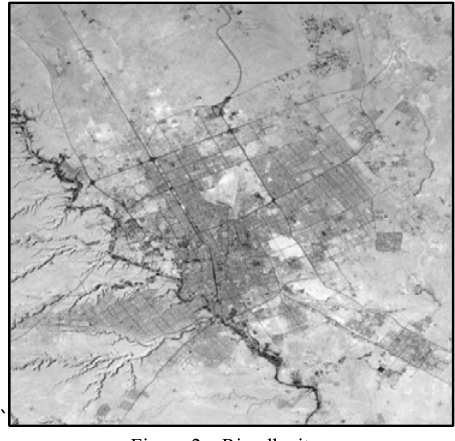
Figure 2a. Riyadh city (Satellite Sensor: Ikonos, GSD:1m,Acquisition Date:2002)